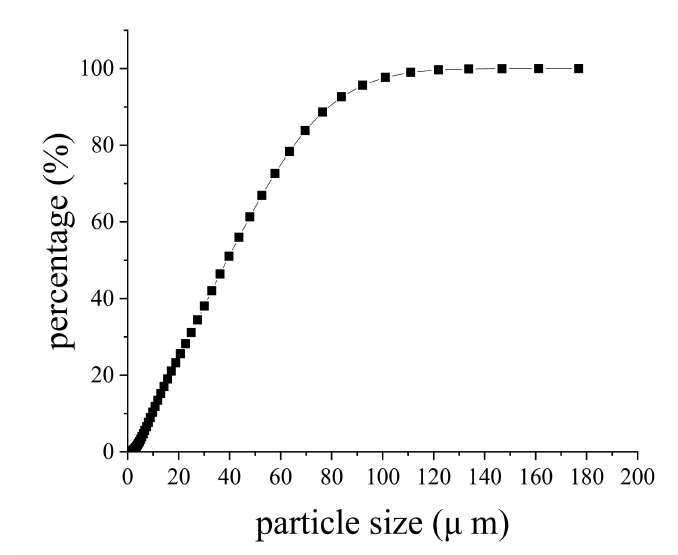
Figure 8. The curve of particle size